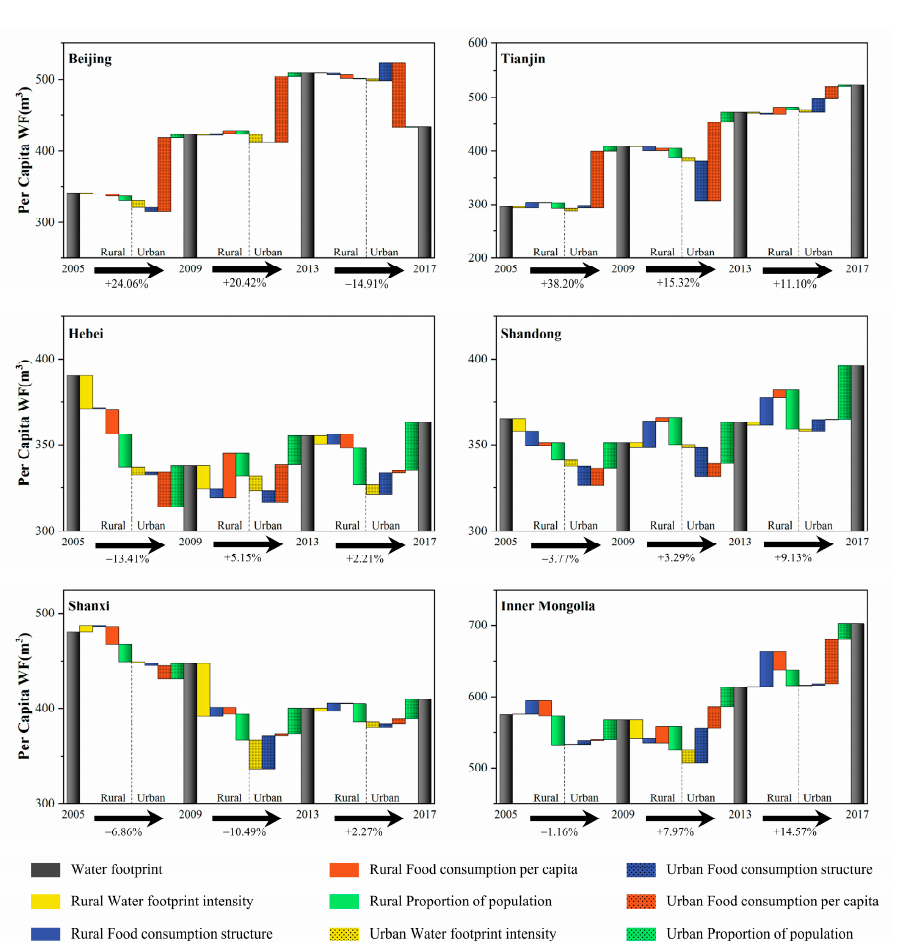
Figure 4. Driving forces to per capita WF change of food consumption in six regions during three